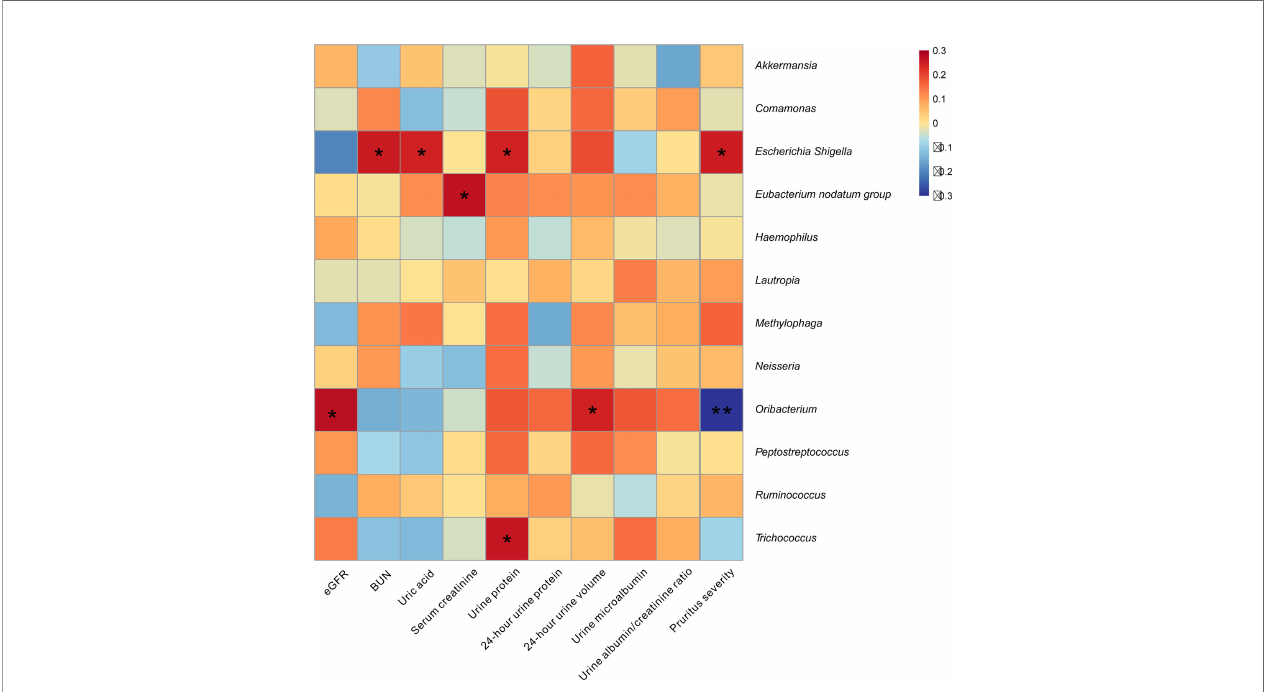
FIGURE 5 | Skin microbiome was associated with pruritus and renal function in CKD patients. The heatmap depicted the association between the taxa which differed in CKD relative to HC and the value of pruritus and renal function in CKD patients. Spearman correlation analysis was performed. The correlation of two variables with values of |r| > 0.3 and p < 0.05 are displayed. * p < 0.05 and ** p <